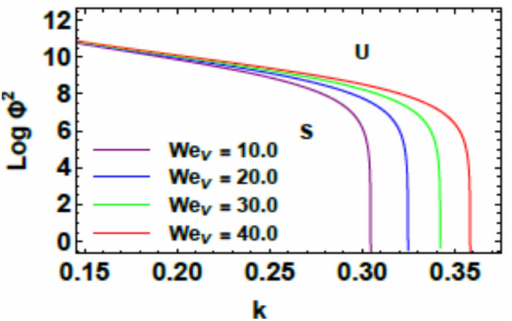
Figure 6. Plots of the stability bound for We v for different values the parameter k versus Log Φ 2 . Figure 7 indicates the influence of Darcy number Da on the stability profile.